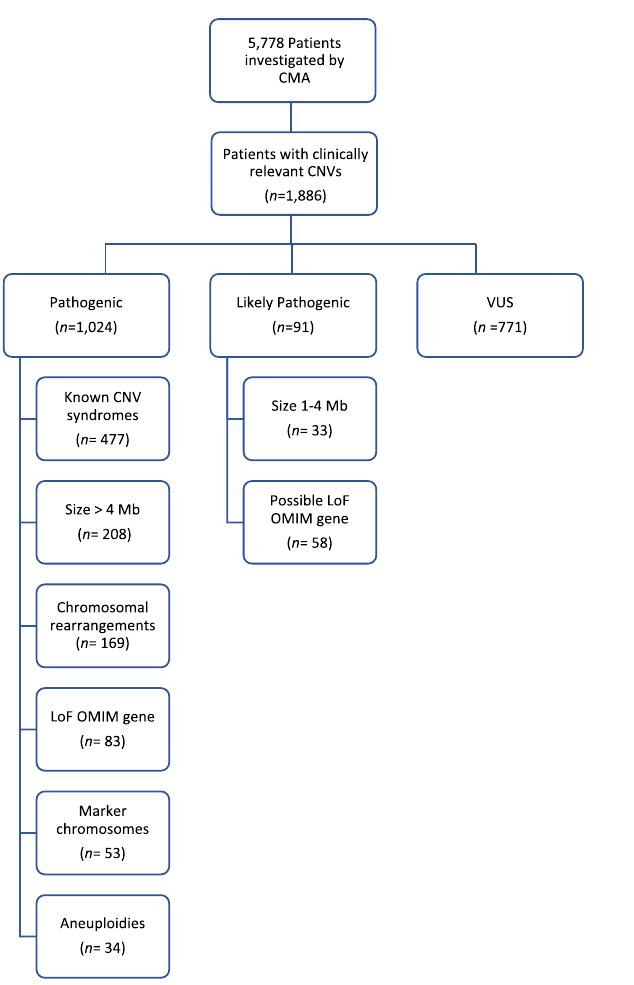
Figure 1. An overview of cases with clinically relevant copy number variations (CNVs) identified in the cohort. The figure shows that, from a total of 5778 patients with neurodevelopmental disorders referred for chromosomal microarray analysis (CMA), 1886 carried clinically relevant CNVs. classified into three main categories: (i) Pathogenic CNVs; (ii) Likely Pathogenic CNVs; and (iii) Variants of Unknown Significance (VUS). The total number of cases corresponding to each category is presented in the diagram. Those individuals with more than one alteration were classified within the most clinically relevant